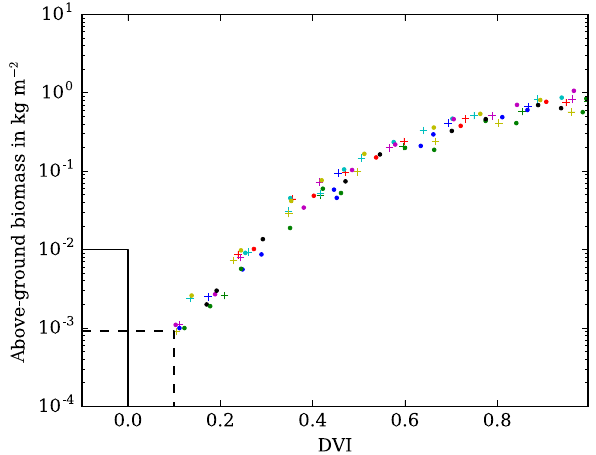
Figure 8. Above-ground biomass measurements against DVI. Dots and vertical crosses (+) are US-Ne1 and US-Ne2 observations re- spectively. Points from US-Ne3 are not shown. Intersection of the solid black line shows the initialisation used in Osborne et al. (2015), intersection of dashed black line shows the initialisation used in this